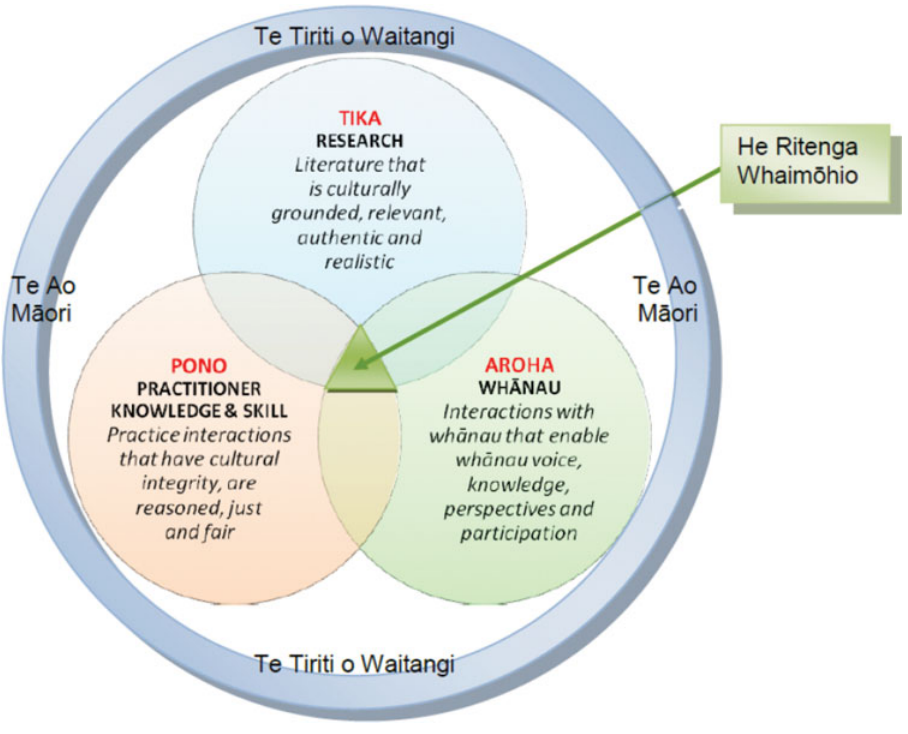
(Colour online) He Ritenga Whaim¯ohio: Culturally Responsive EBP (Macfarlane,